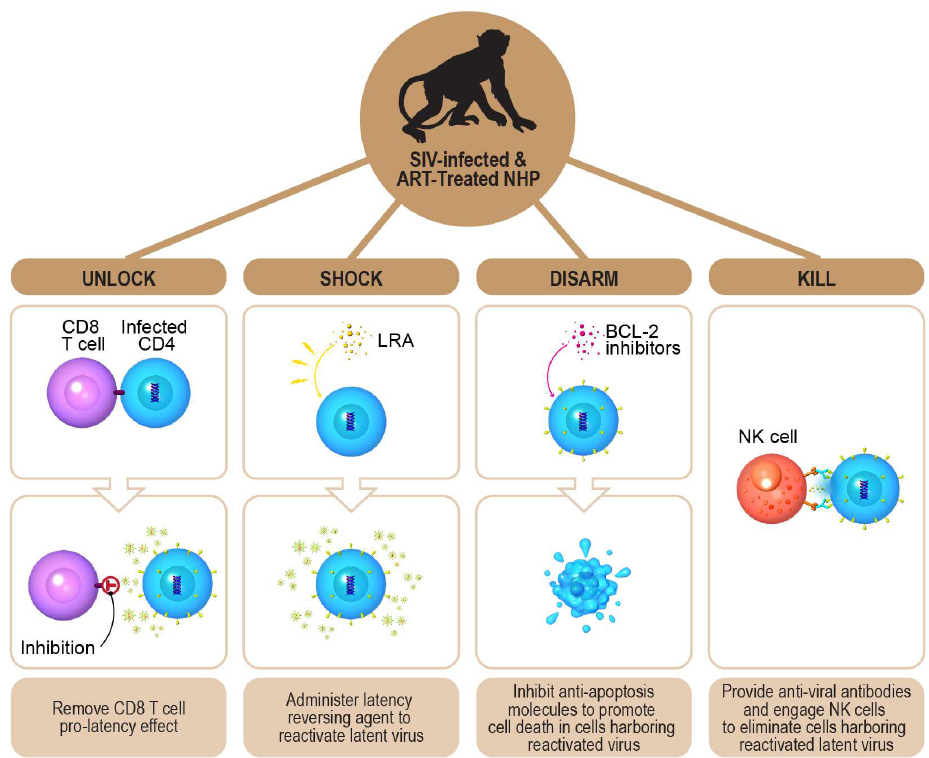
Figure 3. The “unlock, shock, disarm, and kill” strategy for HIV-1 eradication. The diagram depicts the “unlock, shock, disarm, and kill” strategy for HIV-1 eradication in the context of the ART-treated SIV-infected nonhuman primate (NHP) model. This multipronged strategy involves the sequential administration of four interventions. First, ART-treated SIV-infected NHP are administered an agent to inhibit the pro-latency effect(s) of CD8 + T cells, which facilitates the reactivation of latent virus in infected CD4 + T cells. Second, NHP are treated with pharmacological latency reversing agents (LRA), which further reactivate latent virus. Third, inhibitors of anti-apoptosis molecules are utilized to promote cell death in cells harboring reactivated latent virus. Finally, anti-viral antibodies, which recognize native trimeric envelope spikes, are administered to facilitate the recognition cytotoxicity (ADCC) mediated by effector cells such as natural killer (NK)